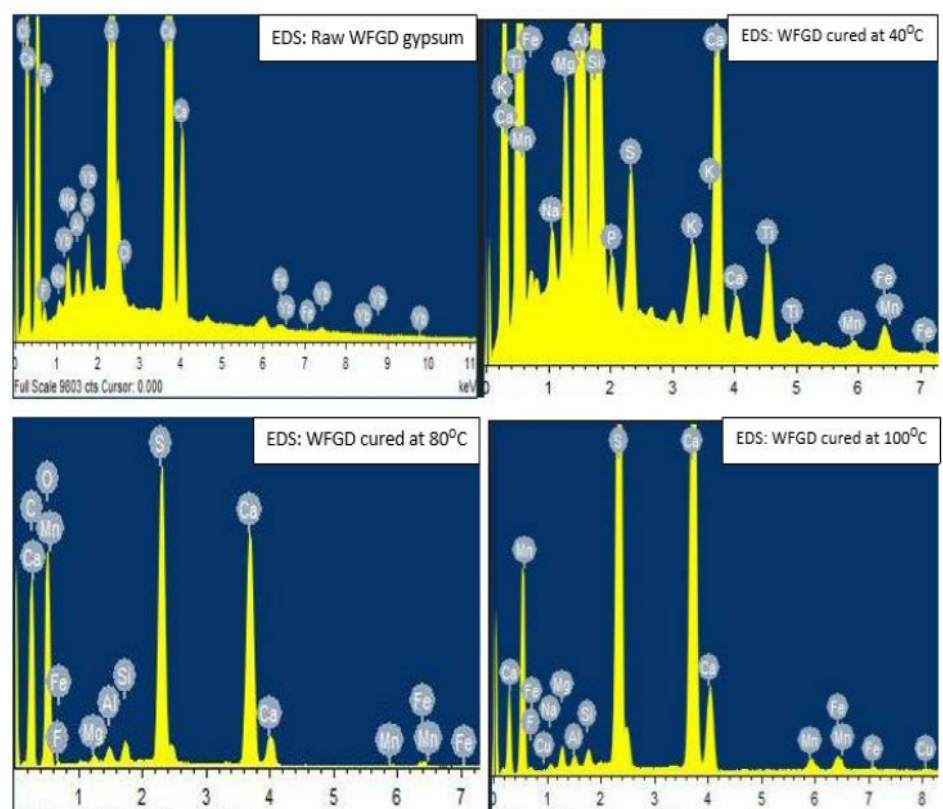
Figure 16. EDS analysis of WFGD gypsum specimens cured at elevated temperatures.